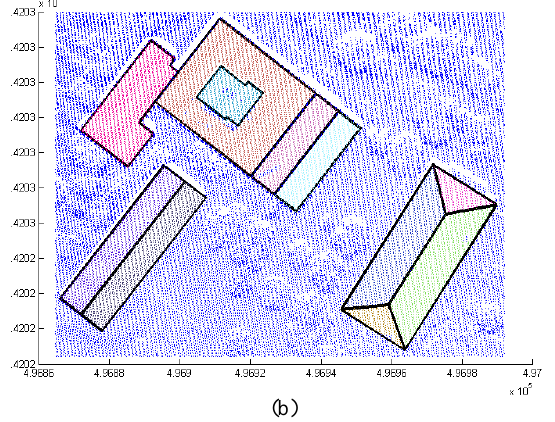
Figure 7. Polylines approximation a) primary lines by using RANSAC algorithm, b) Final lines after applying regularization